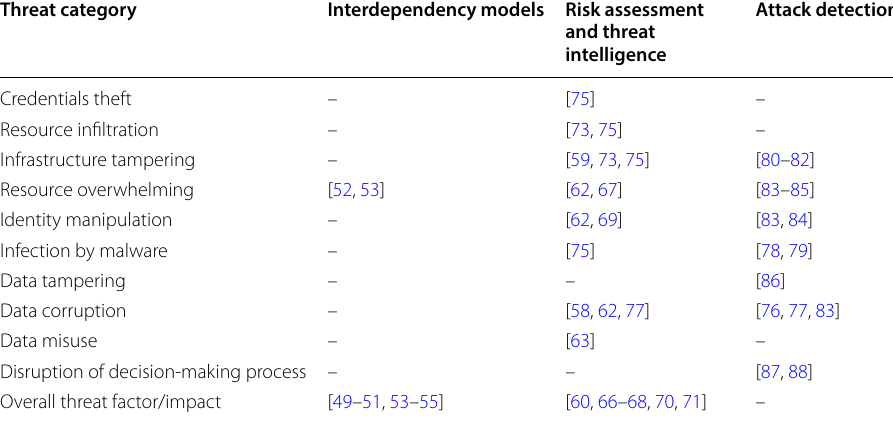
Table 3 Methods supporting cyber situational awareness for smart cities Threat